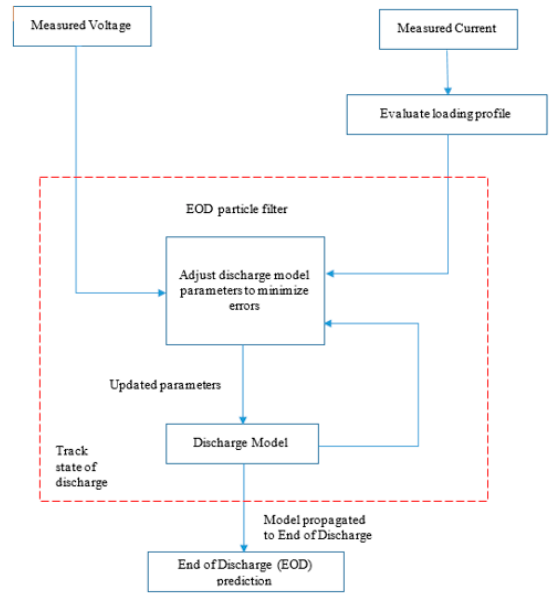
Figure 5. End of discharge (EOD) prediction model.